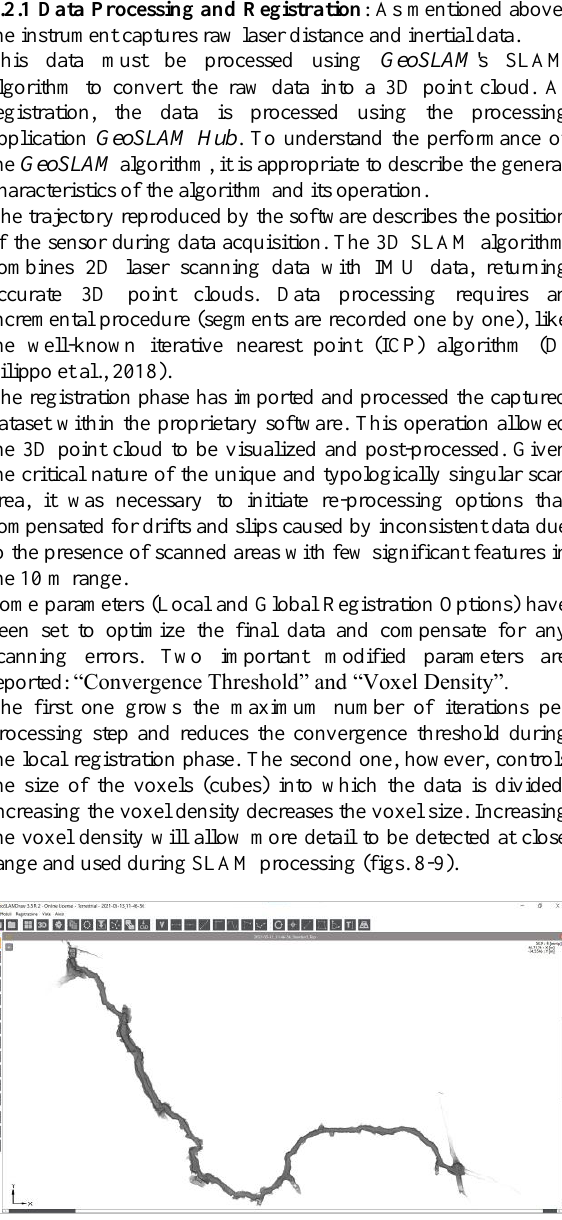
Figure 8 . GeoSLAM Draw interface. Top view in orthogonal projection of the point cloud of the “Gesuitico Alto” qanāt .